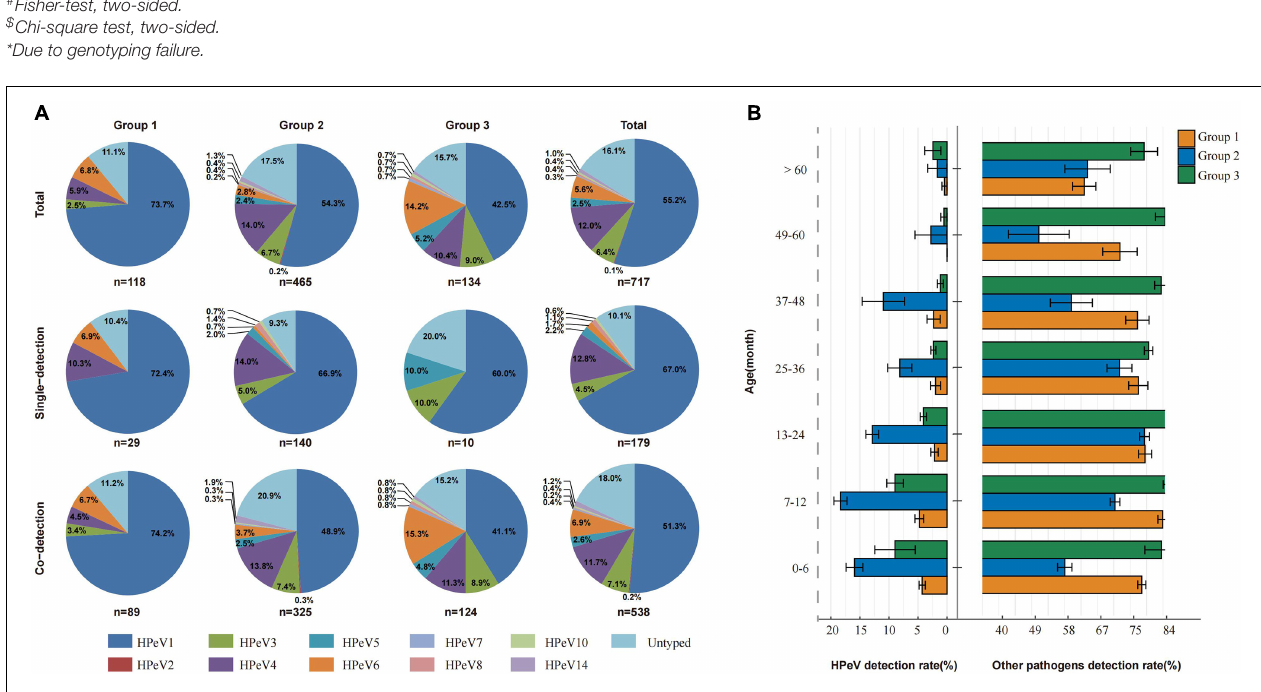
FIGURE 1 | The single infection and co-infection pattern, phylogenetic analysis of all the HPeV, and the age specific pattern of HPeV among three groups of pediatric patients. (A) HPeV single infection and co-infection rate and co-infection pattern between each HPeV genotype and the predominant viruses among three groups of pediatric patients. There were 10 patients coinfected with two genotypes of HPeVs, including HPeV1-HPeV4 coinfection in 7 patients in Group 2, HPeV1-HPeV4 coinfection in 1 patient in Group 3, HPeV3-HPeV6 coinfection in 1 patient in Group 2, and HPeV1-HPeV5 coinfection in 1 patient in Group 3. (B) The age specific pattern of HPeV and other viruses infection among three groups of pediatric patients. Group 1: patients with acute respiratory tract infection (ARTI), Group 2: patients with acute diarrhea, Group 3: patients with hand foot and mouth disease